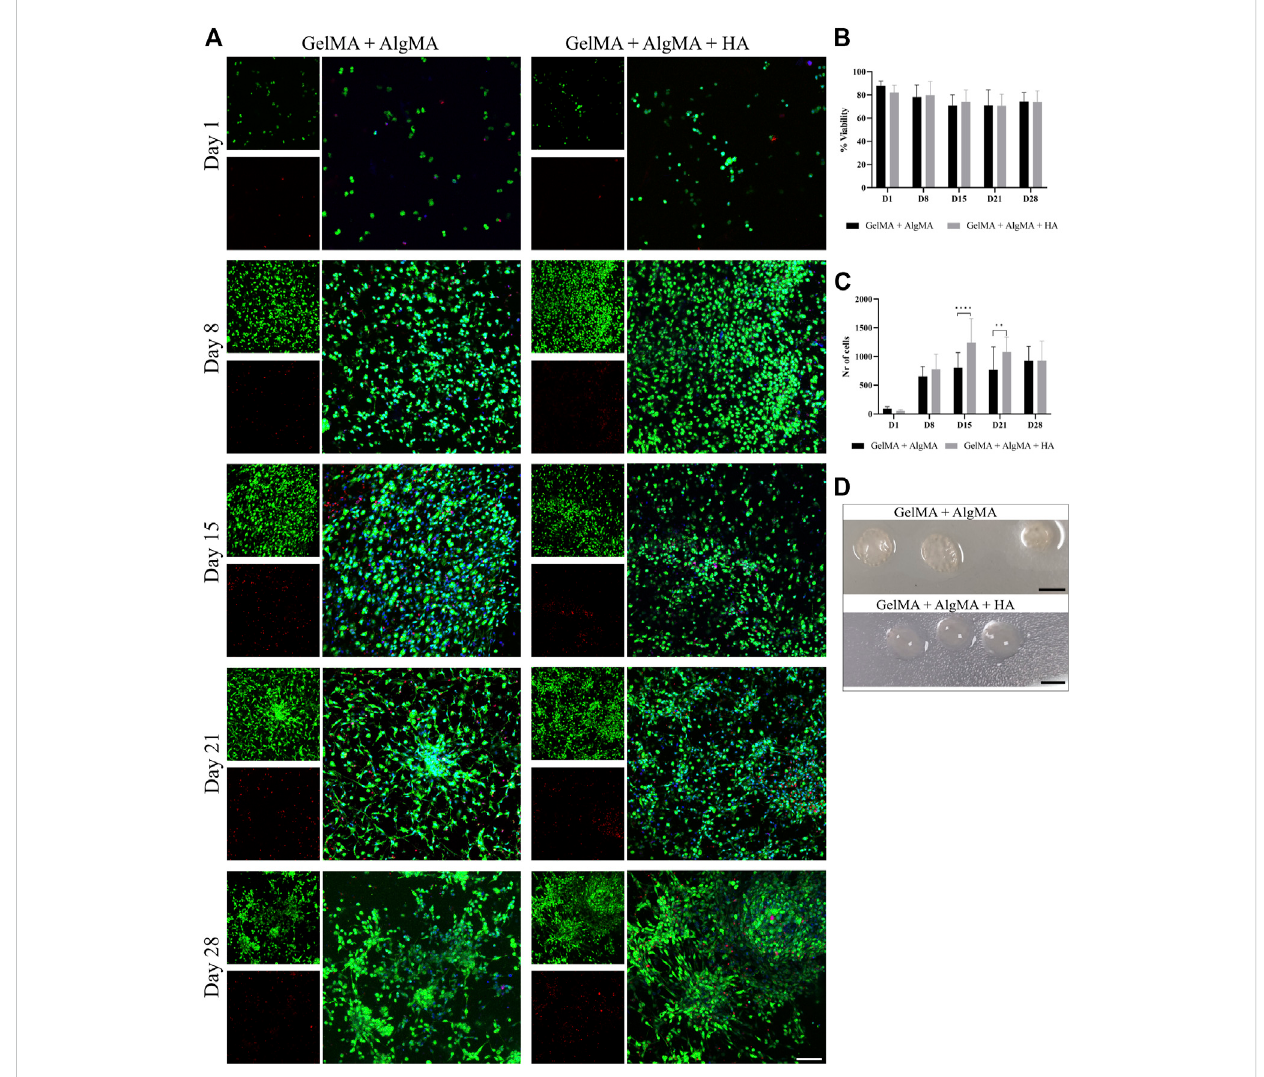
FIGURE 4 Long-term viability assay of C17.2 cells embedded in different concentrations of hydrogels for up to 28 days. (A) Representative confocal images of biocompatibility studies. Nuclei are stained blue, calcein AM in green represents the live cells, and EthD-1 in red represents the dead cells (scale bar 100 µm); (B) quanti fi cationoftheviabilityofthecells; (C) quanti fi cationofthenumberofcellsthroughout28 daysinculture; (D) photosofthesampleson day 28 (scale bar 5 mm). Data are presented as mean ± standard deviation. Statistical signi fi cance was calculated using a two-way variance analysis (ANOVA) with Sídák ’ s post hoc multiple comparisons test considering ** p < 0.01; **** p <